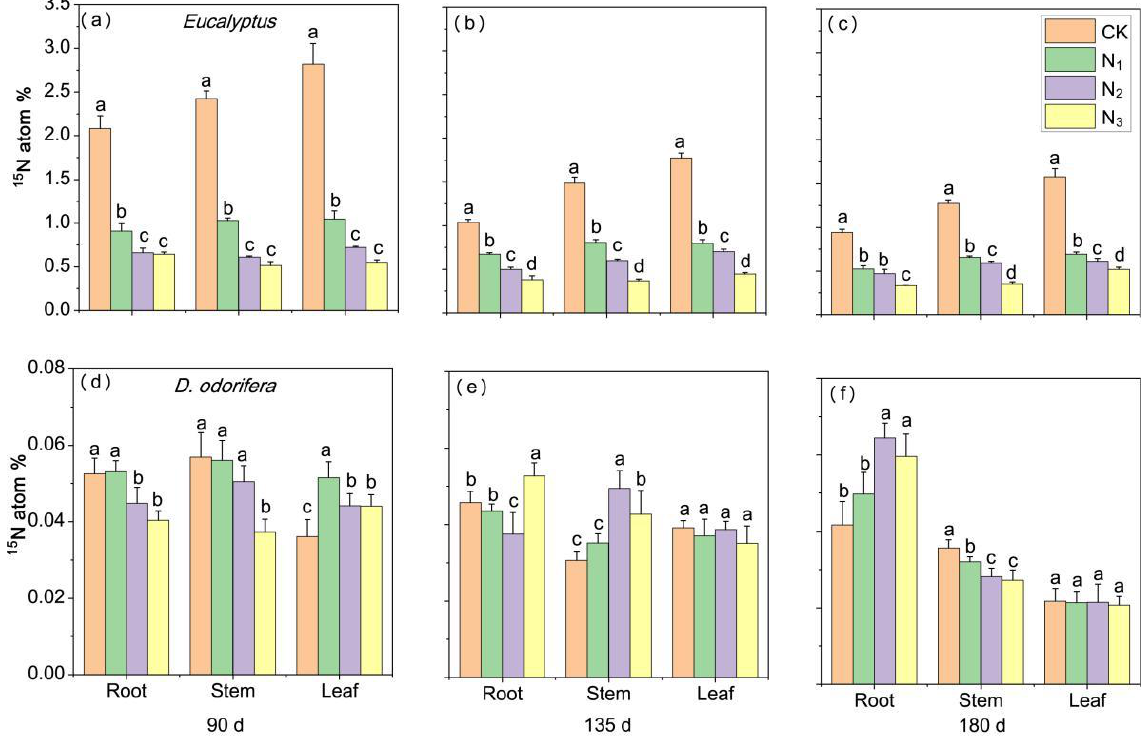
Figure 4. Atom% 15 N in excess in plant components of both species in pots where Eucalyptus was labeled at different N levels (i.e., E. urophylla × grandis as the 15 N donor and D. odorifera as the receiver plant), where atom% 15 N is the difference between atom% 15 N 90, 135 180 days after labeling and atom% 15 N before labeled . Panels ( a – c ) show the atom% 15 N of E. urophylla × grandis , and panels ( d – f ) show the atom% 15 N of D. odorifera . CK indicates plants without N application, and N 1 , N 2 and N 3 correspond to N fertilizer application rates of 3, 6 and 12 g urea (CO( 14 NH 2 ) 2 ) pot − 1 , respectively. The different lowercase letters above the bars indicate significant differences among N treatments ( p < 0.05). Error bars indicate ± SE ( n = 4).